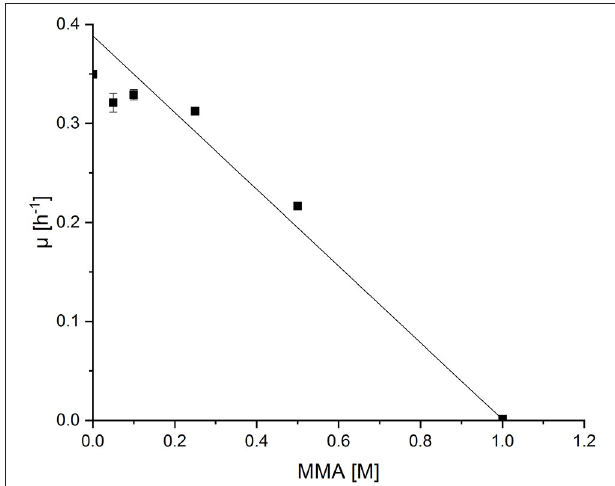
FIGURE 2 | Growth rates of P. putida KT2440 grown in the presence of varying concentrations of MMA. P. puida KT2440 wild type strain was grown in minimal medium supplemented with increasing MMA concentrations (0.05 M – 1.0 M) and growth rates were determined. Half maximal effect on growth rate was determined by linear fit ting (OriginLab, Northampton, MA).